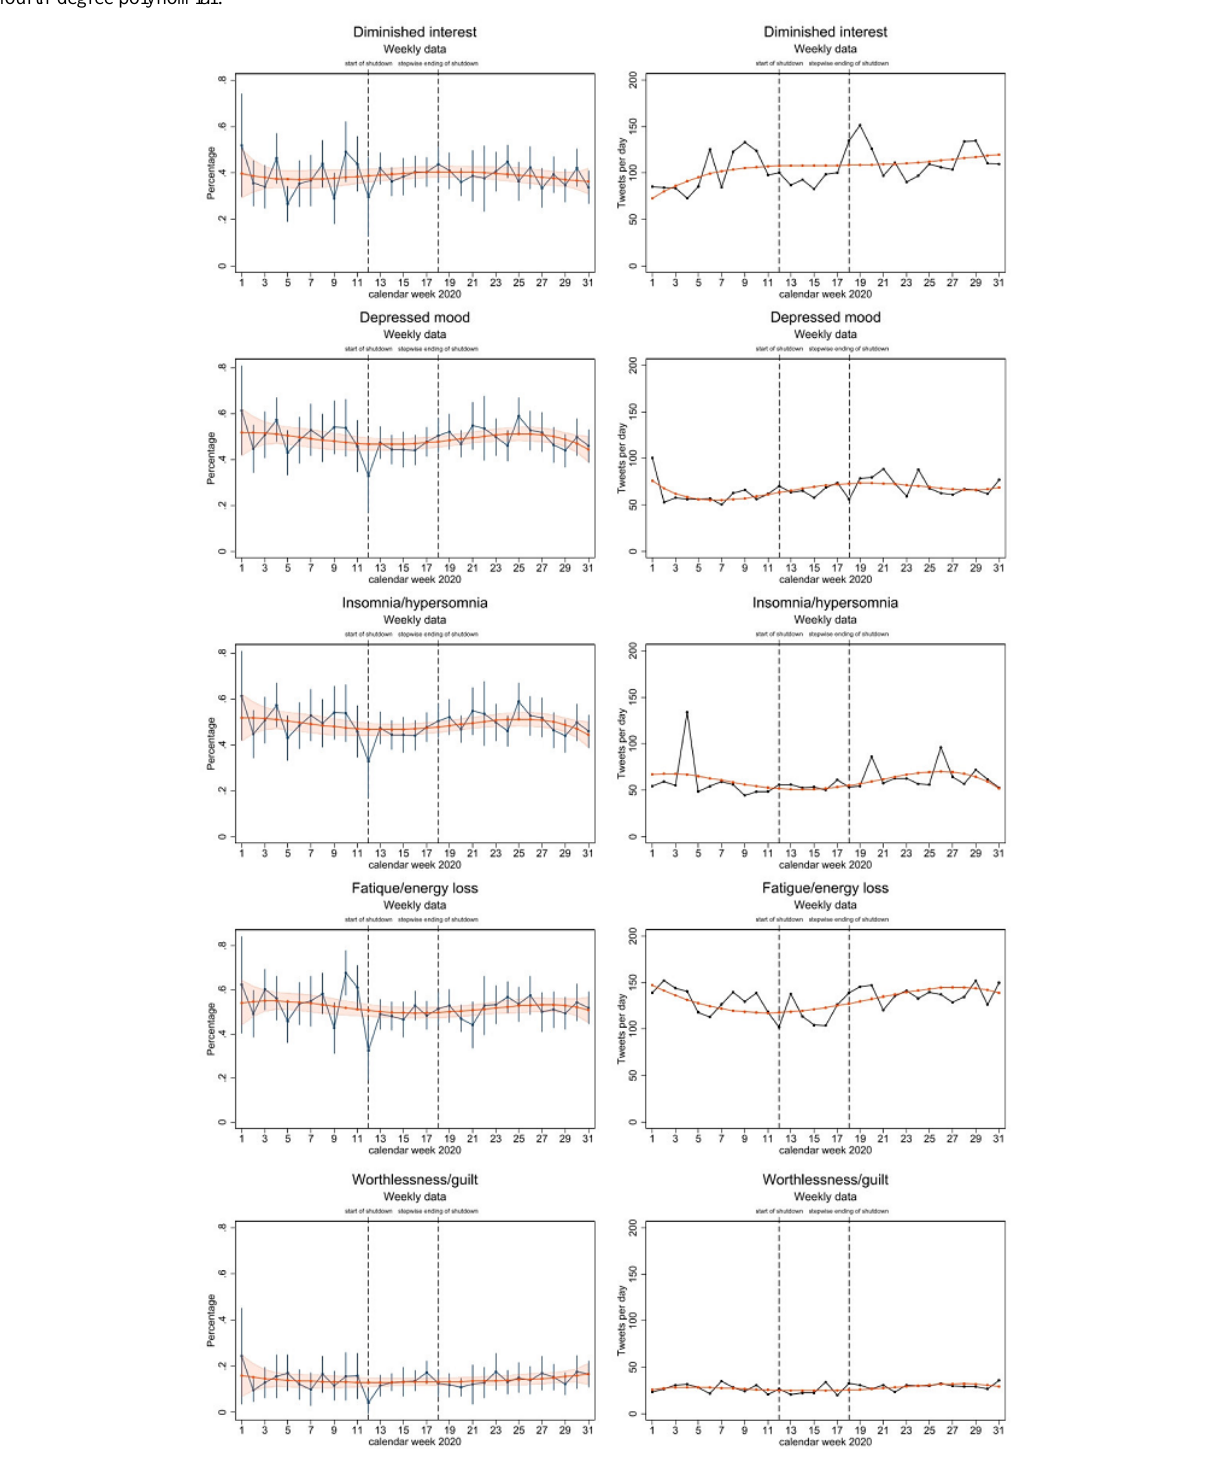
Figure 2. Temporal progression of five depressive symptoms in the survey data (on the left) and Twitter data (on the right) from January to August 2020 (calendar weeks 1-31). The dark gray line represents the weekly averaged frequency, and the orange line represents the smoothed progressions by fourth-degree